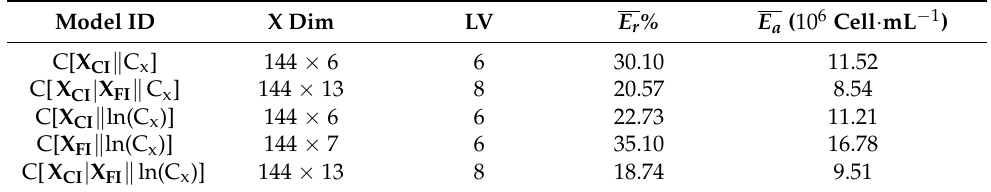
Table 2. Performance of the models used to estimate biomass concentration. Note that, when the logarithm is predicted, the final values were converted back into concentration and errors were